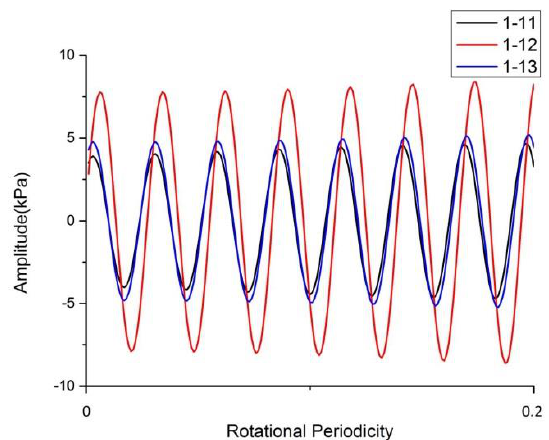
( b ) Near the choke point. Figure 21. The comparison of the pressure frequency spectrums between the near choke and design conditions inside R1 .